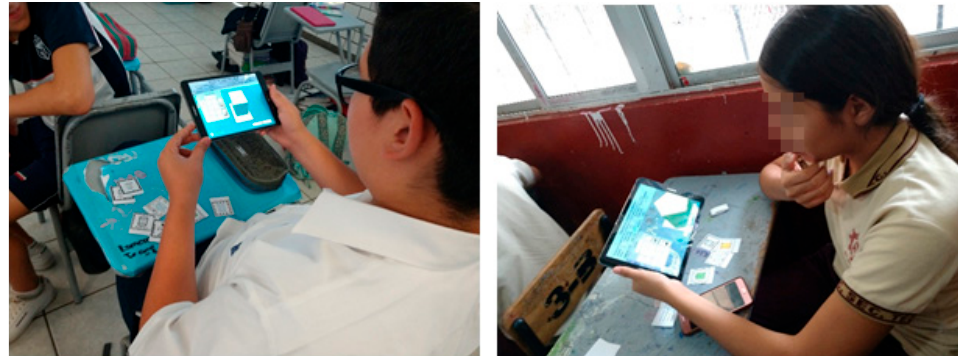
Figure 3. Students using the learning tool.